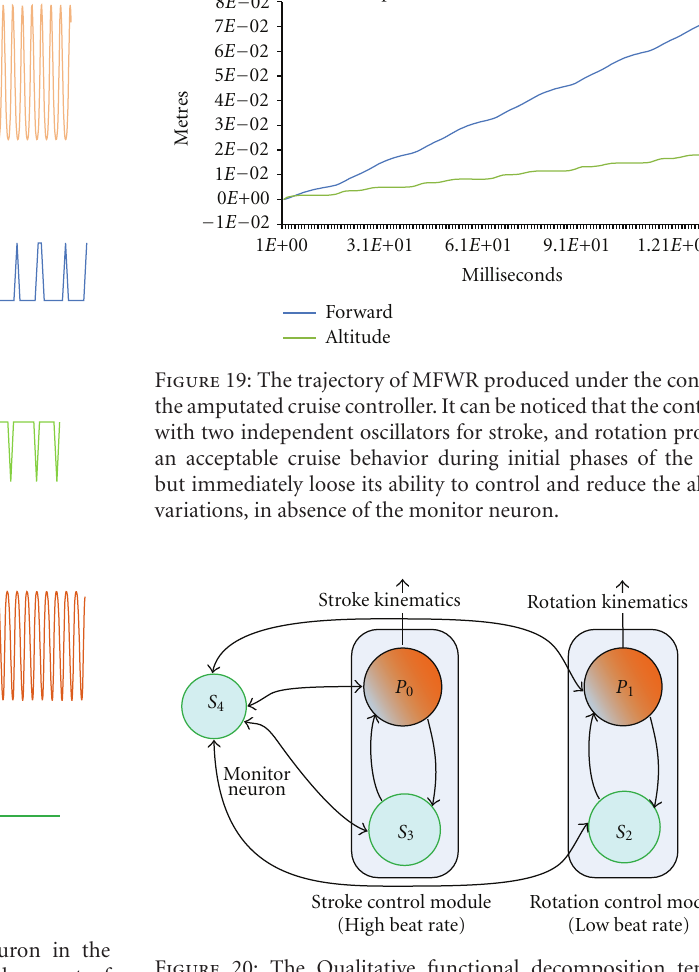
Figure 20: The Qualitative functional decomposition template derived for the autonomous cruise mode. Most of the autonomous cruise mode controllers can be decomposed into the above-shown template with a high frequency stroke control oscillator module and a low frequency rotation control oscillator along with an intermediate neuron called monitor neuron, which is responsible to coordinate and fine-tune the amplitude and frequency of the stroke oscillator with a period derived from the rotation oscillator. This functional template explains the general evolved behavior of the amplitude and frequency modulation of the stroke kinematics with rotation period for optimal cruise control of